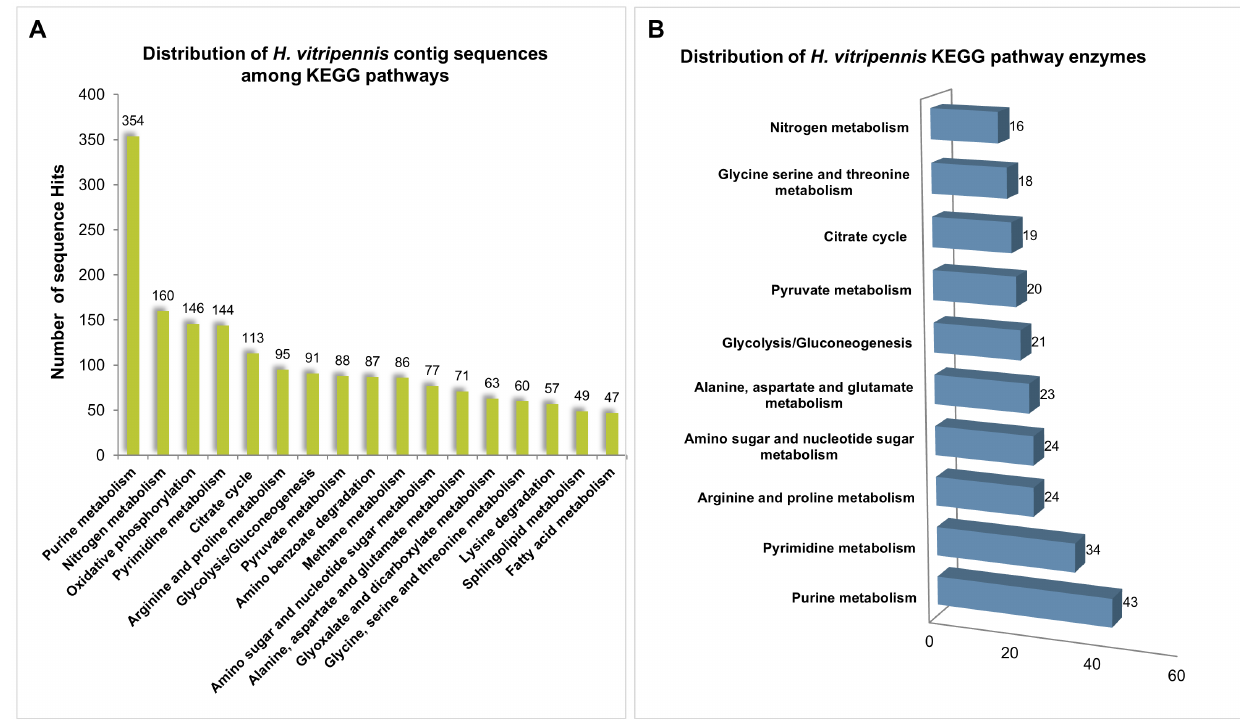
Figure 4. Summary of H.vitripennis KEGG pathways. A ) Distribution of KEGG pathway sequences of H . vitripennis is shown as a bar chart. The number of sequence hits is shown along the Y-axis while the different KEGG pathways are shown along the X-axis. B ) The top ten KEGG pathway distributions in the H. vitripennis genome are represented as a bar diagram. KEGG pathway enzymes were represented along Y-axis and the numbers of enzymes are represented along X-axis.